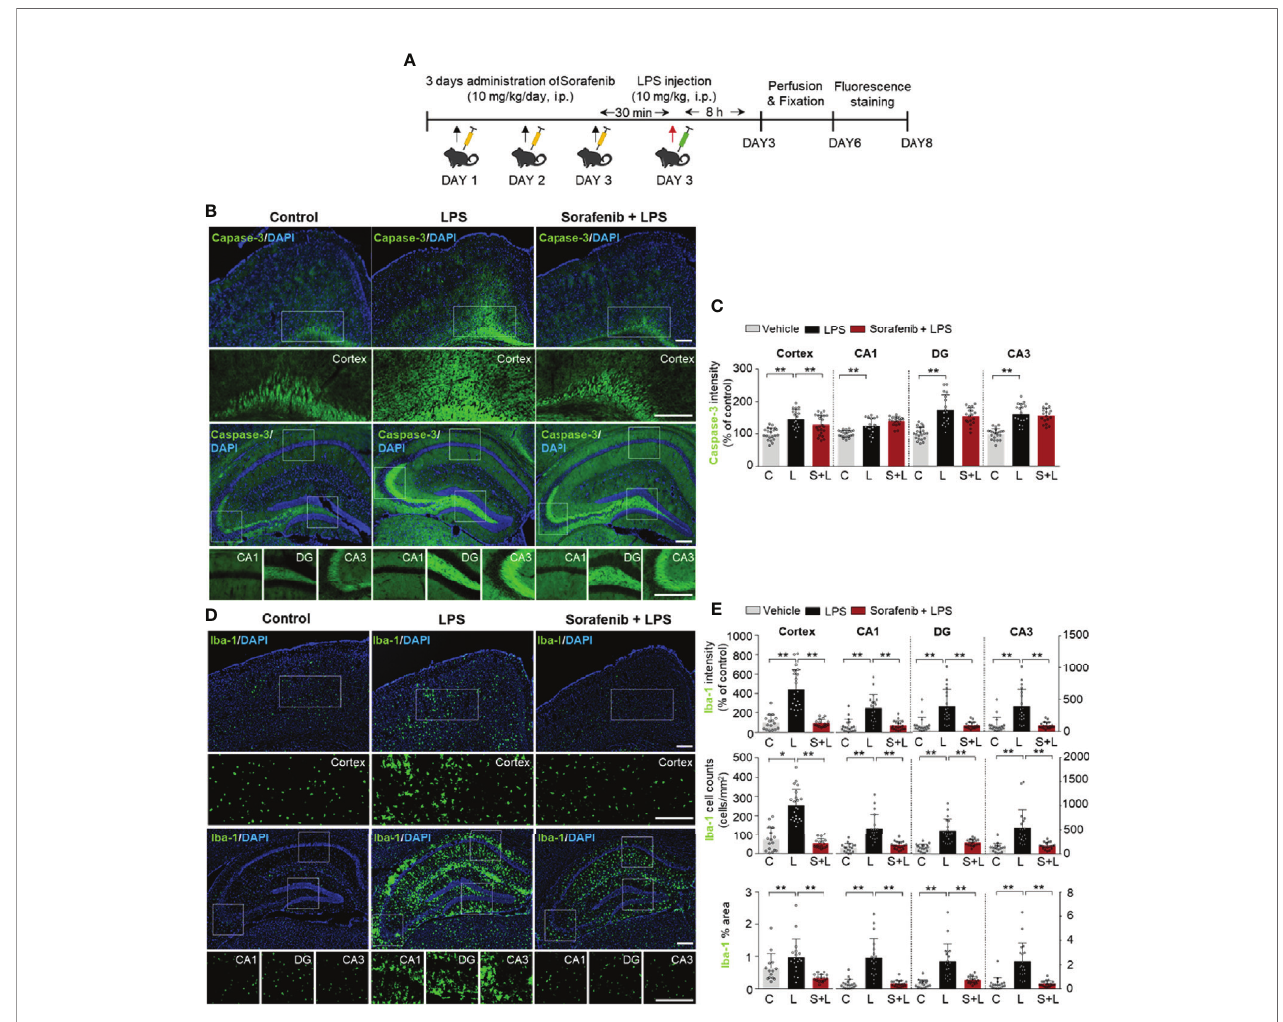
FIGURE 3 | Pretreatment of sorafenib inhibits LPS-induced microgliosis in wild-type mice. (A) Scheme for treatment of wild-type mice with sorafenib followed by LPS. (B, D) Immuno fl uorescence staining of brain slices from wild-type mice treated as described in (A) with an anti-caspase-3 and anti-Iba-1 antibody. (C, E) Quanti fi cation of the data in (B, D) (analyzed number of brain slices/images (n); Caspase-3: Vehicle, n=21; LPS, n=18; Sorafenib + LPS, n=21, Iba-1: Vehicle, n=18; LPS, n=19; Sorafenib + LPS, n=19). *p < 0.05, **p < 0.01. Scale bar = 200 m